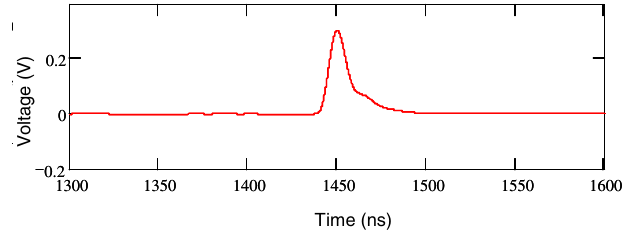
FIG. 16. (Color) IF simulated signal from the (cid:1) channel with 10 mm beam offset.